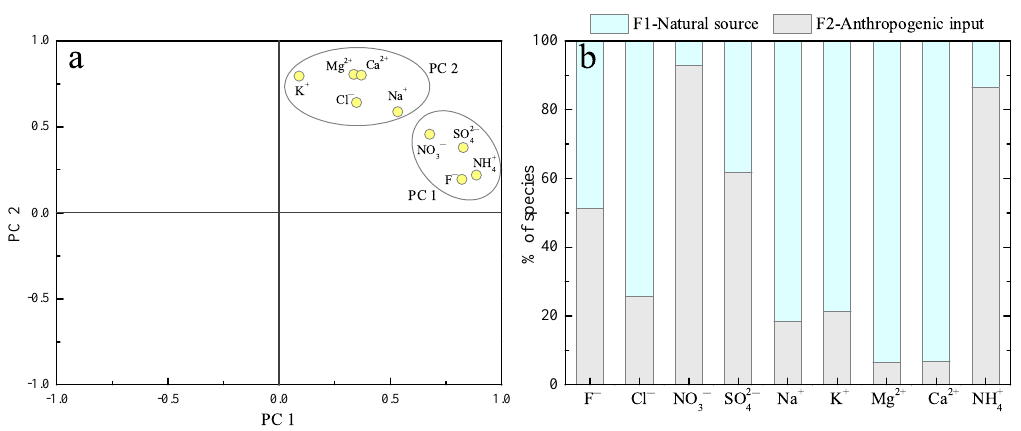
Figure 8. ( a ) The principal component analysis of rainwater ions and ( b ) positive matrix factorization (PMF)-extracted relative contribution fractions of anthropogenic and natural sources to rainwater ions in the